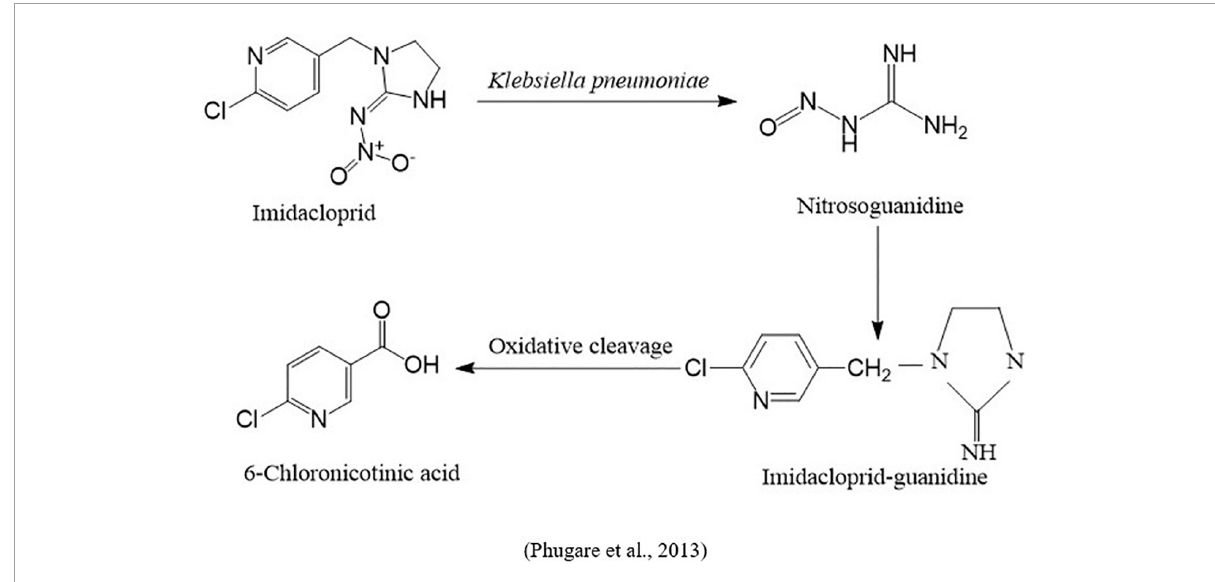
FIGURE6 Microbial metabolic pathway of imidacloprid degradation by insect gut